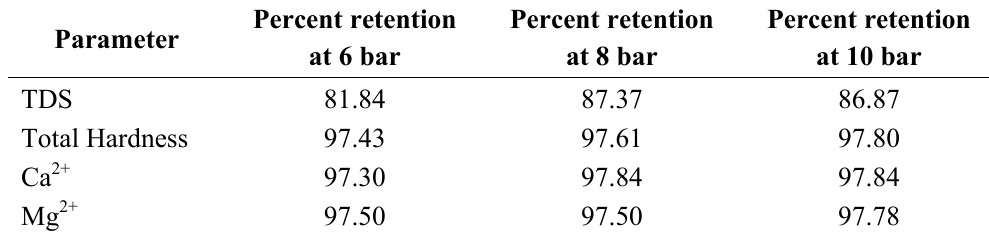
Table 5. Retention percentage (% R ) of TDS, total hardness, Ca 2+ and Mg 2+ at various pressures for Sample 2.